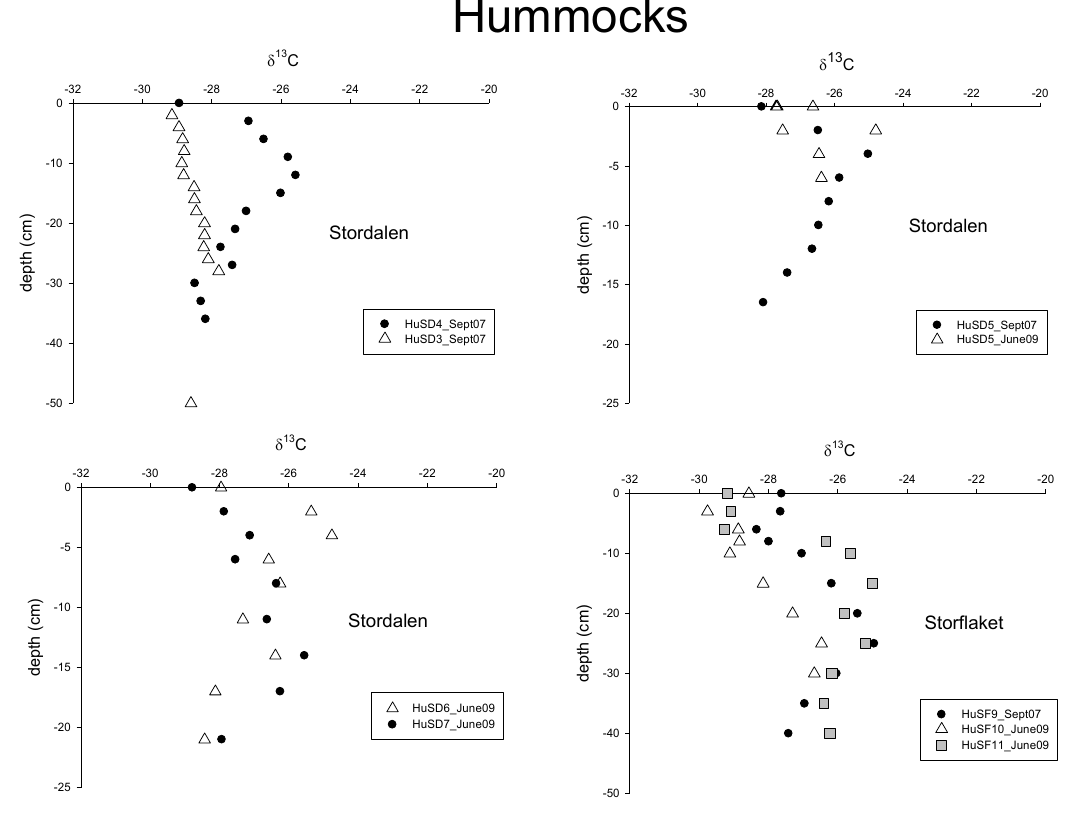
Fig. 3. Isotope depth profiles of the investigated hummocks. δ 13 C in ‰.